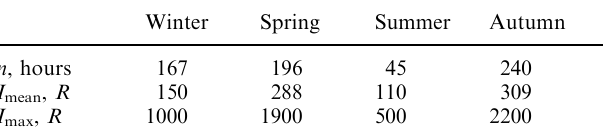
Table 1. Seasonal variations of SAR arc occurence and intensity